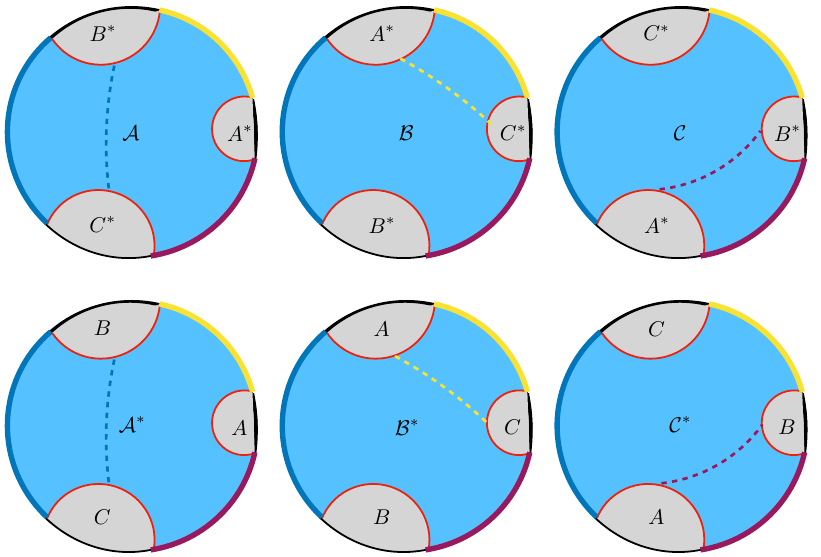
Figure 9 . The 6 copies each labeled in the center. Each gray region labels which copy the surface will be glued to. Note the pieces of Σ connect sequentially Σ( A ) to Σ( B ) to Σ( C ) etc. forming a double cover.